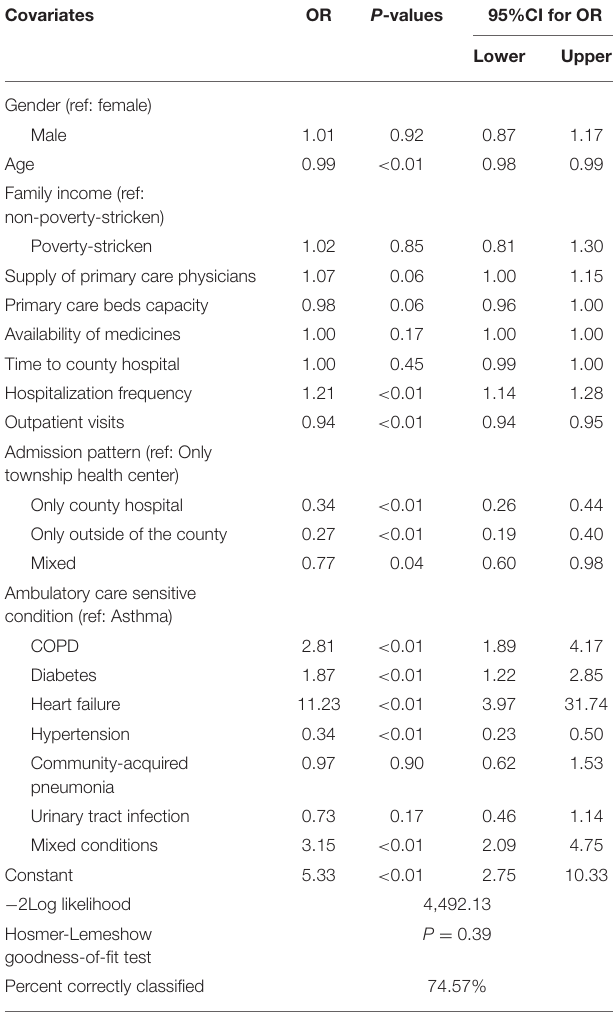
TABLE 3 | Factors associated with potentially preventable hospitalizations among high-cost patients. Overall High-cost Covariates OR P -values 95%CI for OR Non-high- ( n = 180,431) patients cost patients ( n = 18,043) ( n = 162,388)